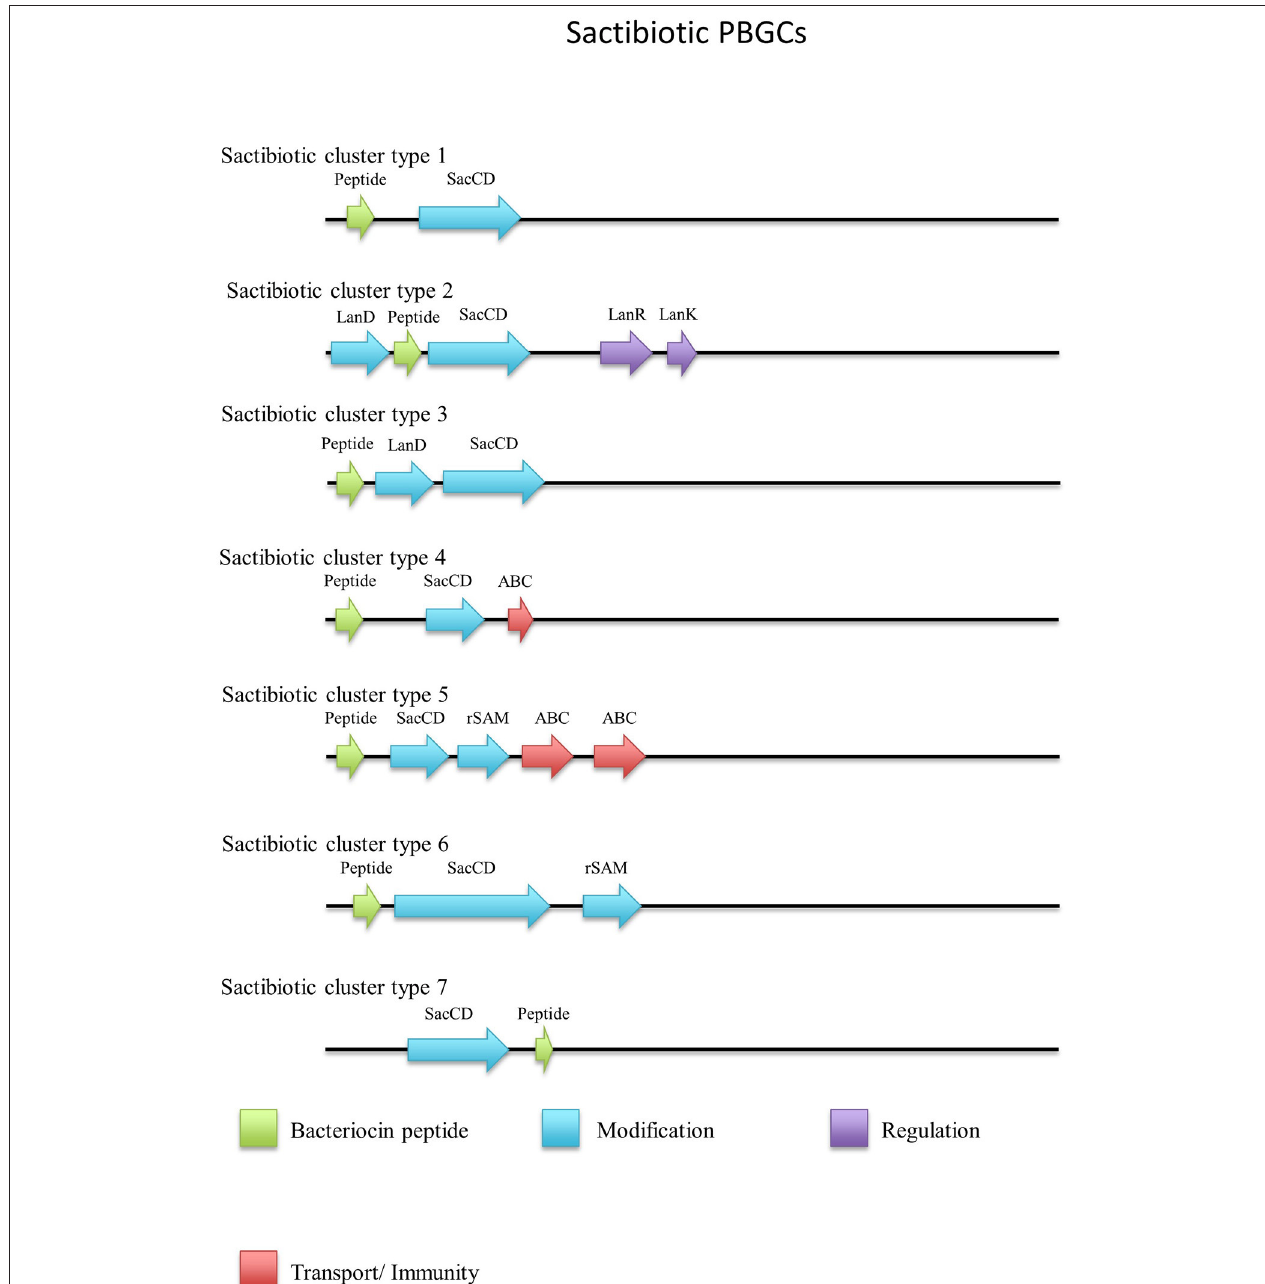
FIGURE 5 | Sactibiotic cluster types predicted by BAGEL3.